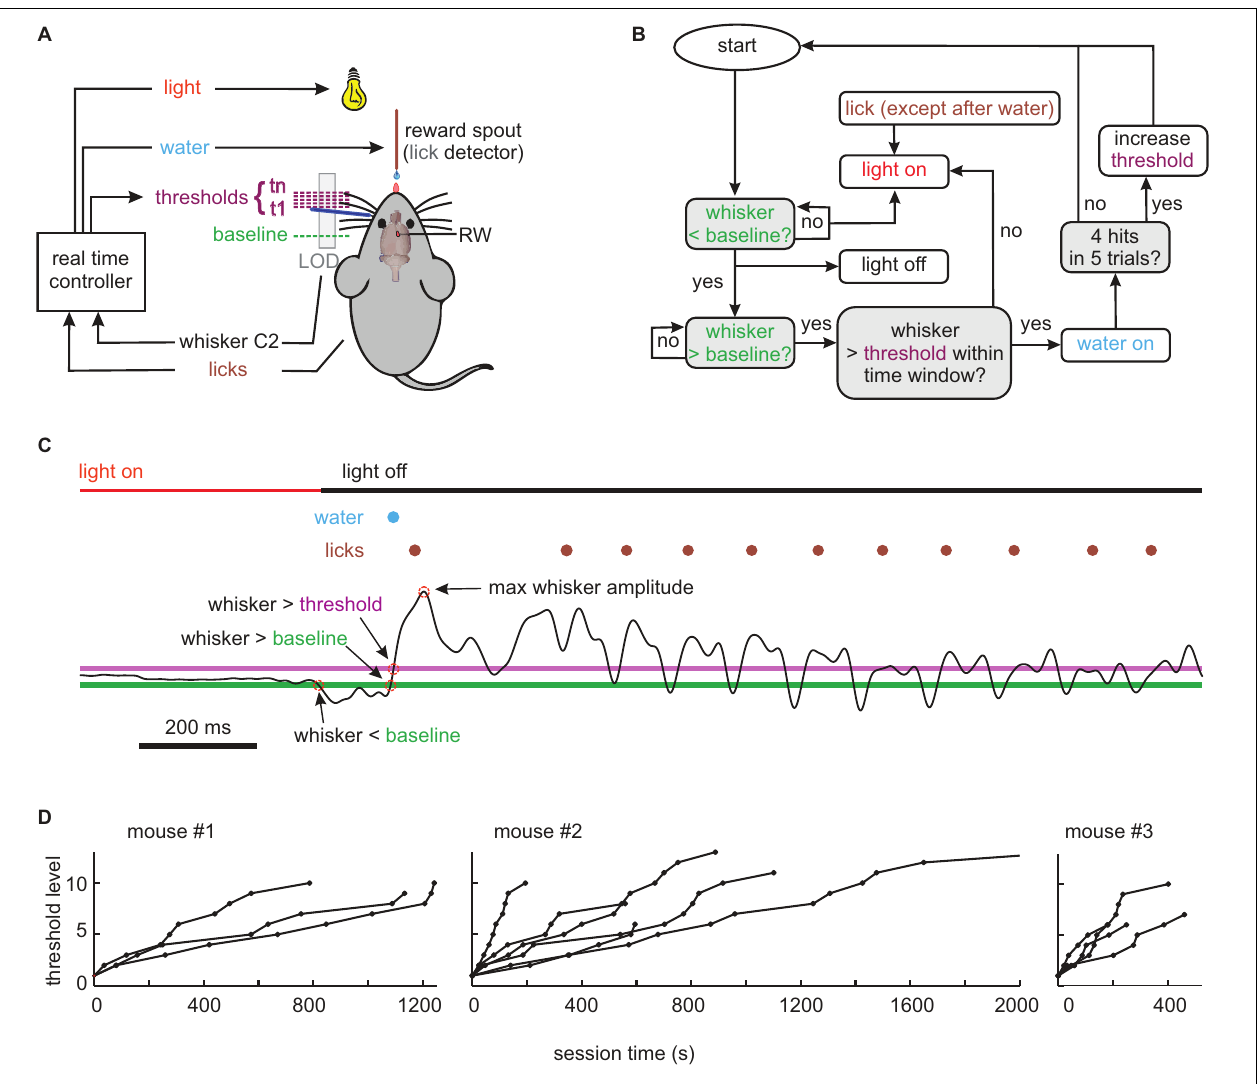
FIGURE 1 | Behavioral (A) setup. The movement of whisker C2 (dark blue) of a head-fixed mouse is monitored in real-time by a laser optical device (LOD). The task of the mouse is to bring its whisker in starting position behind a baseline. A trial is started by protracting C2 across a baseline and successfully concluded (rewarded by a drop of water) by crossing a variable threshold. Light OFF signals that a trial can be started. (B) Flowchart of experimental control. Colors match those in panels (A,C) . Decision points are marked with gray boxes. (C) Example of a successful trial, i.e., going to a start position behind the baseline (green, first red circle) turning the house light OFF; moving forward across baseline (second red circle) and threshold (magenta, third red circle) within a preset time, reward delivery (blue), and licking (brown). Whisker trajectory is the thin black line (whisk amplitude fourth red circle). Colors match those in panels (A,B) . (D) Progression of threshold levels (threshold increment per level: 0.93 mm) across session time in all pre-lesion sessions of the three mice.